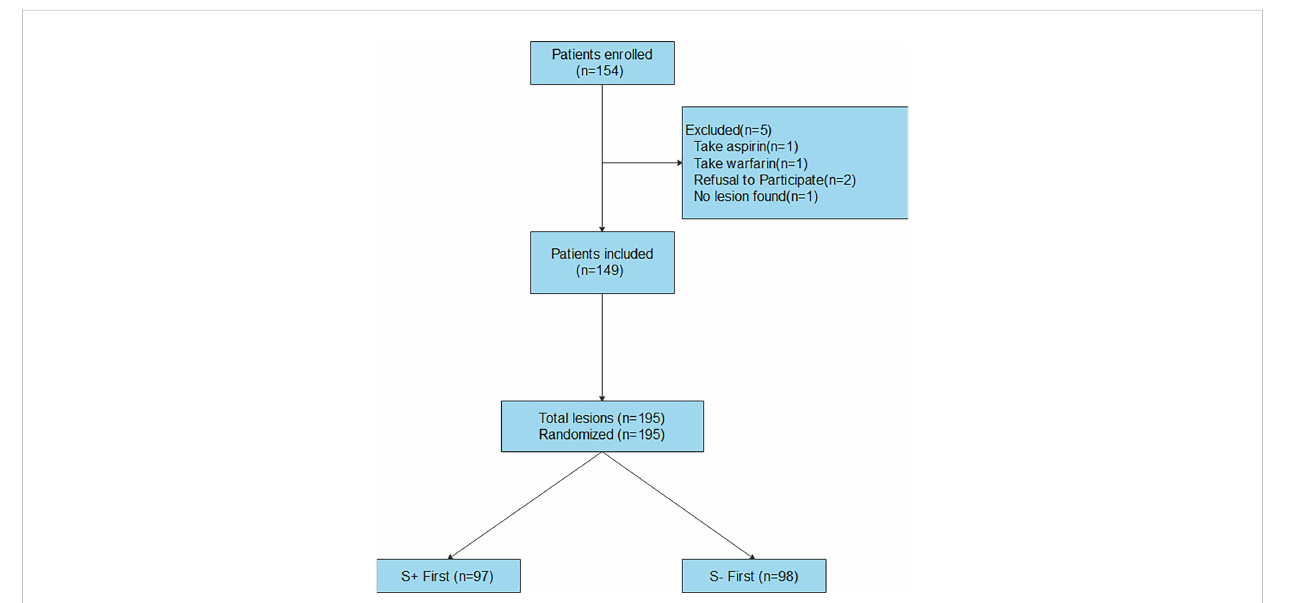
FIGURE 1 Flow diagram for 154 consecutive patients referred for thyroid nodules fi ne needle aspiration